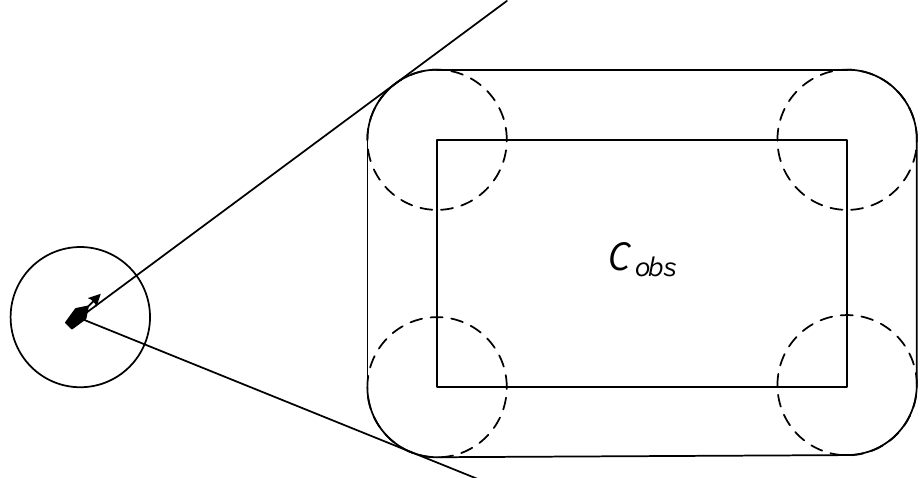
Figure 9. Avoidance of polygonal obstacles. In Figure 9, C obs represents the obstacle domain.